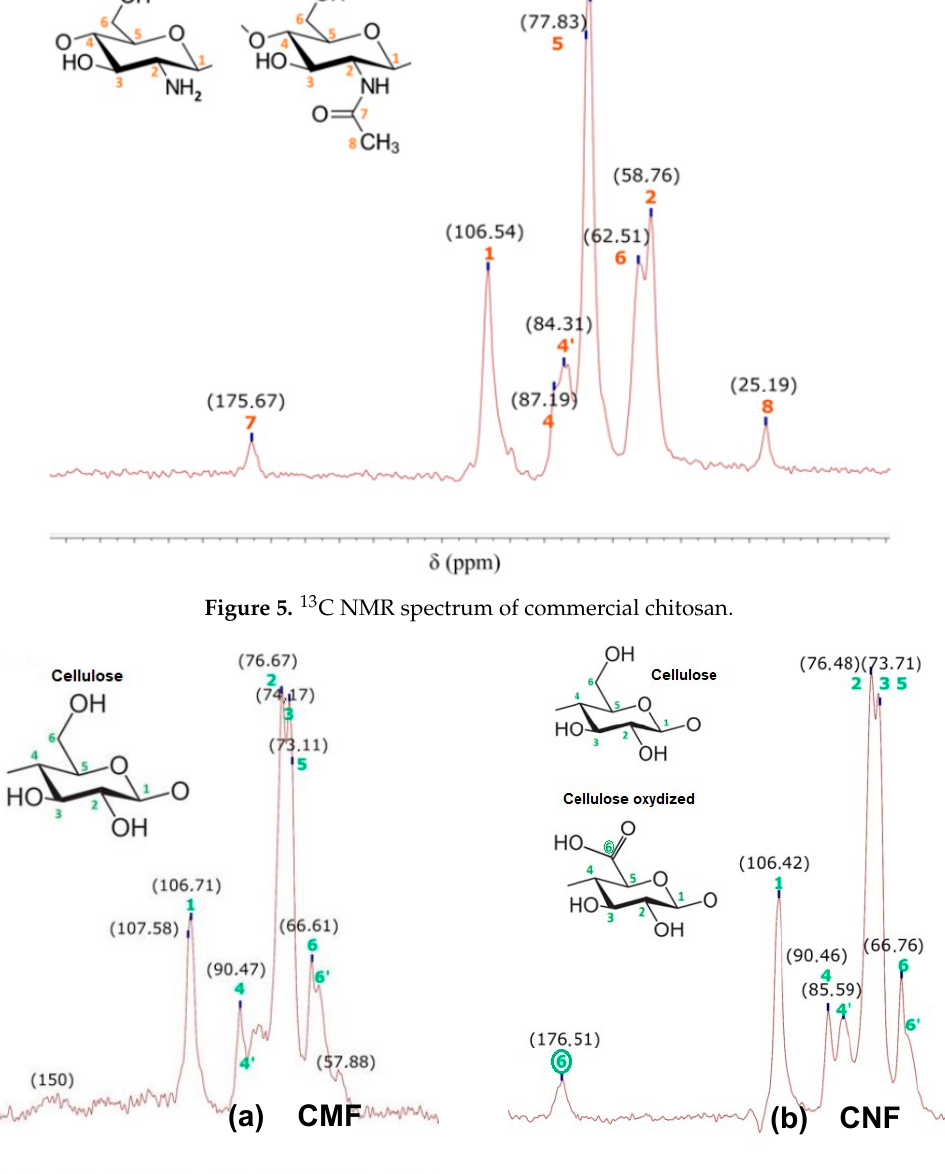
Figure 5. 13 C NMR spectrum of commercial chitosan.